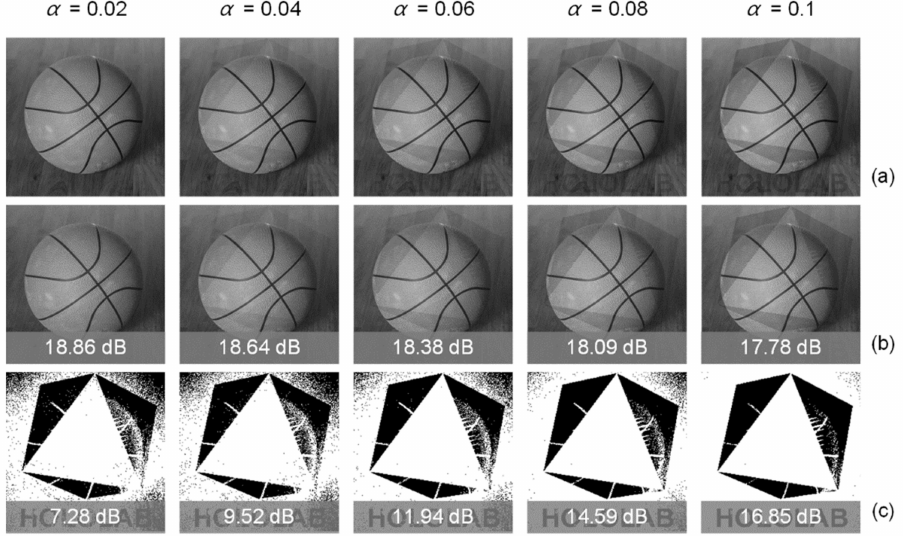
Figure 9. ( a ) The watermarked images with different values of α . ( b ) The reconstructions of decrypted CGHs. ( c ) The extracted watermarks from the